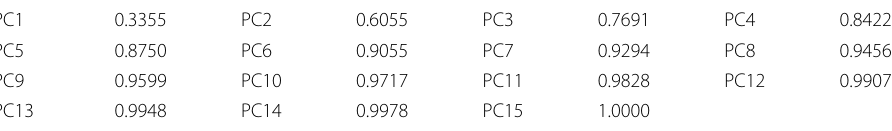
Table 2 Cumulative proportions of variability explained using the PCA results